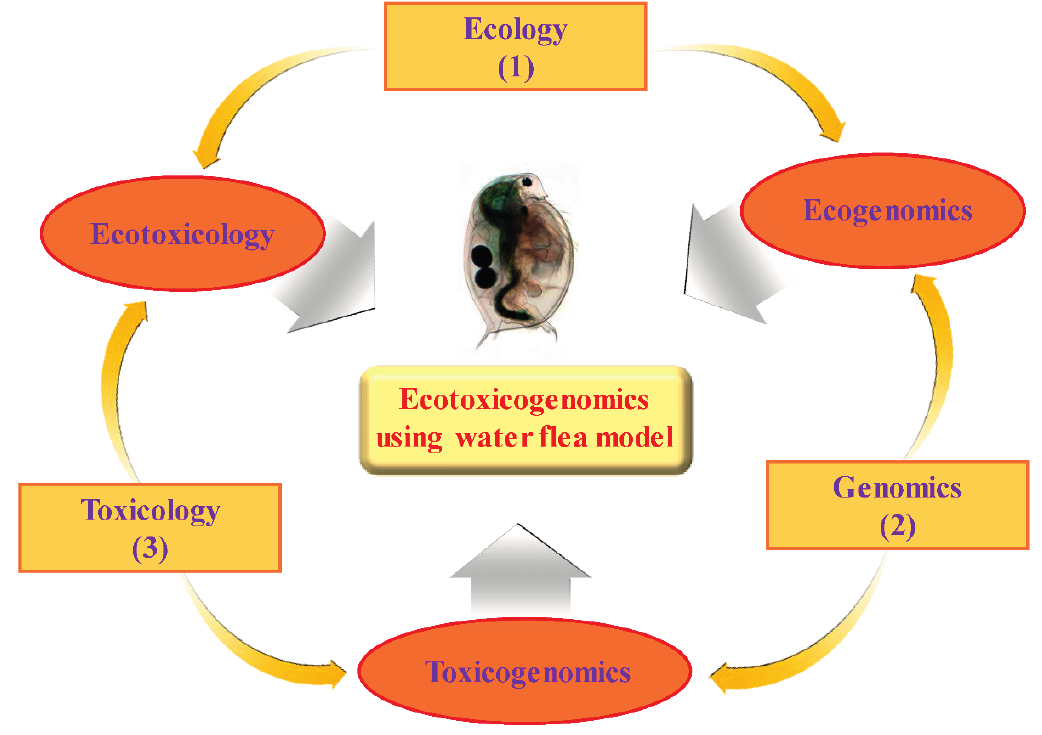
Figure 1. A scheme illustrating conceptual ecotoxicogenomics using Daphnia model. The thin arrows connect primary fields of study (in rectangles) to form interdisciplinary fields (in circles). The thick arrows indicate the tools or the knowledge that can be applied to integrated multidisplinary data sets, for instance: (1) ecological surveys; (2) genomic tools; (3) toxicity